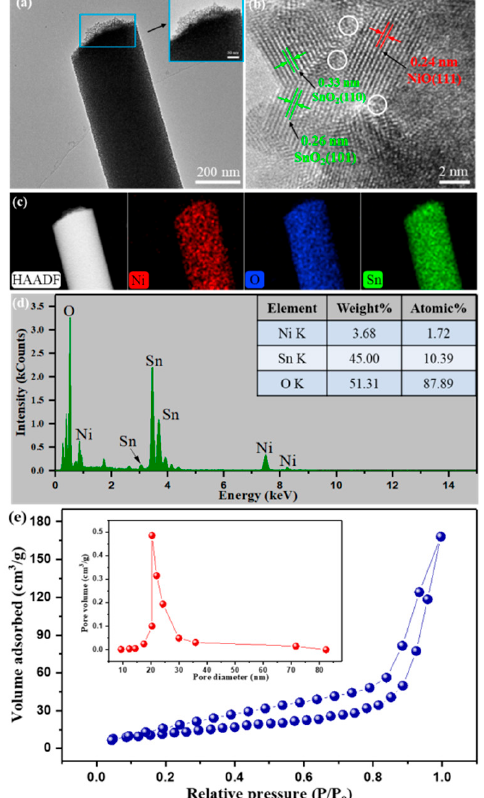
Figure 4. ( a , b ) High resolution transmission electron microscopy (HRTEM) images of the NiSn / 4; ( c ) high angle annular dark field (HAADF) image and element mapping of a single NiSn / 4 nanofiber; ( d ) The energy dispersive X-ray spectroscopy (EDS) spectrum of NiSn / 4 nanocomposite. ( e ) The N 2 adsorption-desorption isotherm and pore size distribution curve (inset) of the NiSn / 4